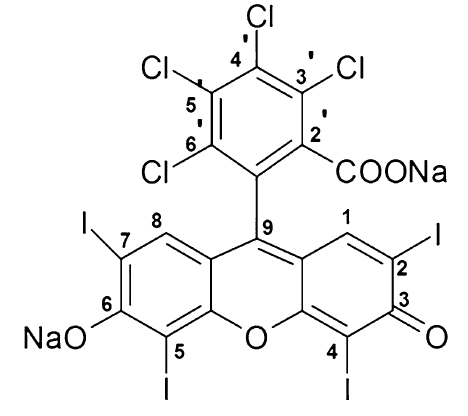
Fig. 1 Chemical structure of rose bengal